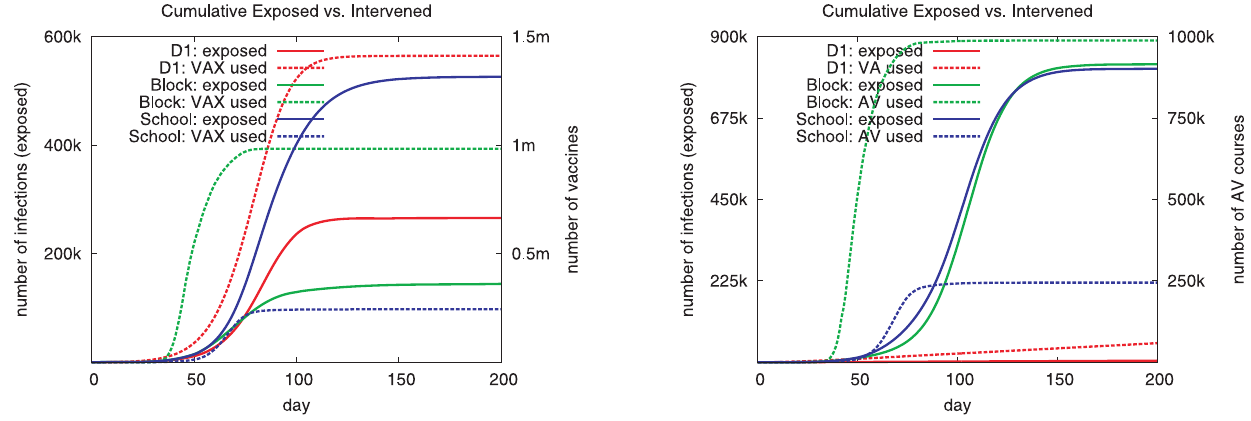
Figure 2. Cumulative number of people exposed versus the cumulative amount of vaccine and antiviral used under each of the three strategies considered. On the left, cumulative number exposed versus the cumulative number of vaccines used; on the right, the cumulative number exposed versus the cumulative courses of antivirals used. D1 refers to the bottom-up strategy, and Block and School refer to the top-down strategies. The parameters settings used here include high transmissibility i.e. 40% infection attack rate, diagnosis probability of 1, threshold value of 0.01, and the compliance probability of 0.5.